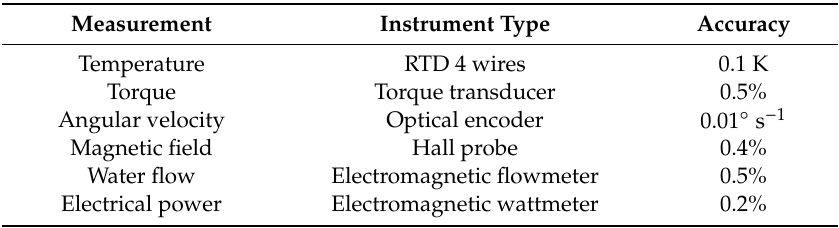
Table 1. Measurement instruments used for the experimental tests.